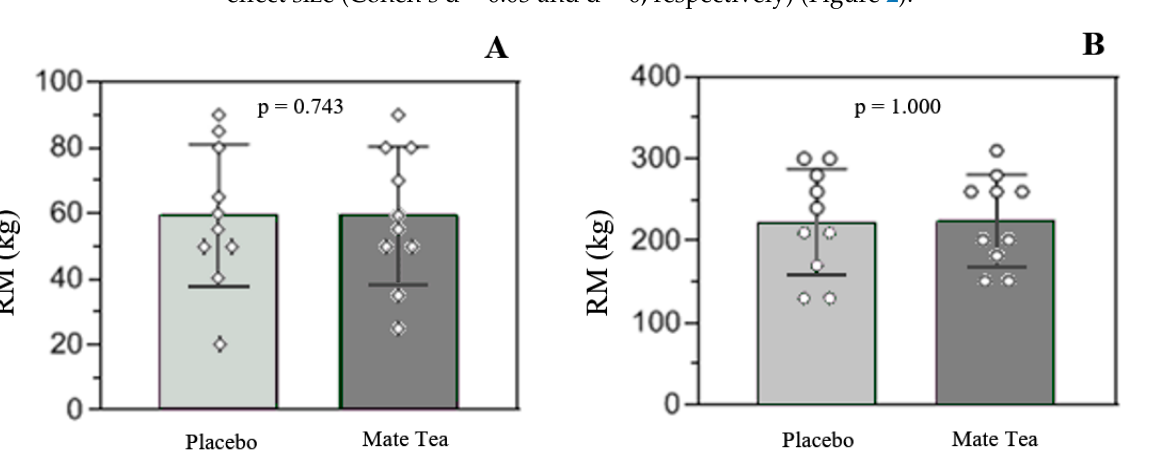
Figure 2. Load results (kg) in the 1RM protocols, comparing the interventions (placebo vs. mate tea). ( A ) RM result for the bench press exercise. ( B ) RM result for the leg press exercise. Values presented as mean and standard deviation.